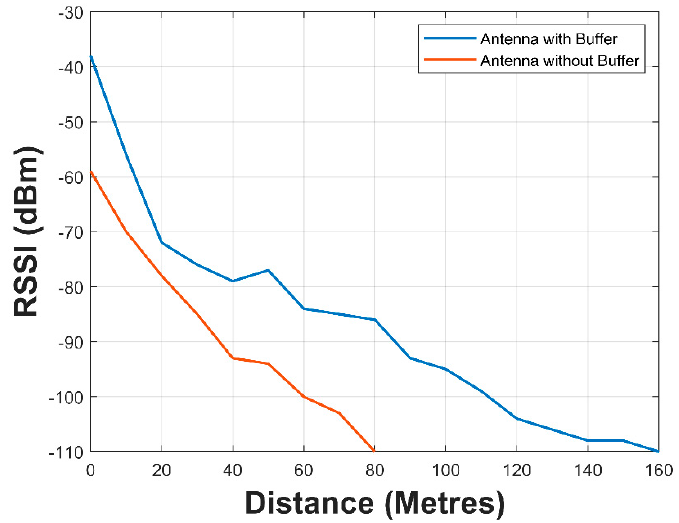
Figure 18. RSSI tests for buffered and barrierless antennas.